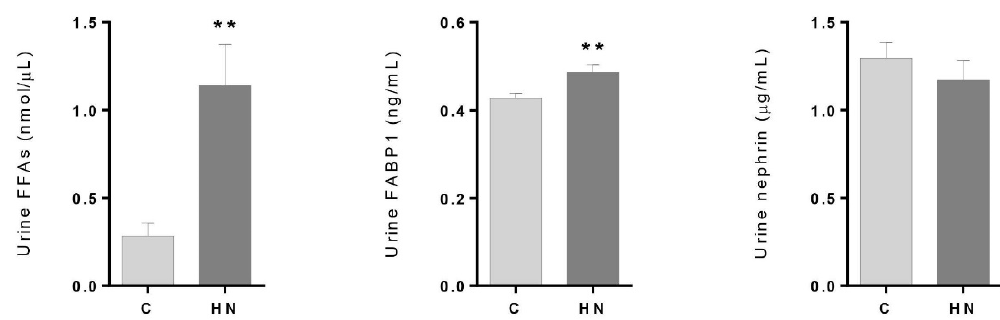
Figure 3. Urinary concentration levels of free fatty acids (FFAs), fatty acid binding protein 1 (FABP1) and nephrin between control subjects (C; ACR < 10 mg/g) and subjects in the high–normal range (HN; ACR = 10–30 mg/g). Error bars show standard error media. A Mann–Whitney non parametric test (95% confidence level) was performed (** p < 0.01).